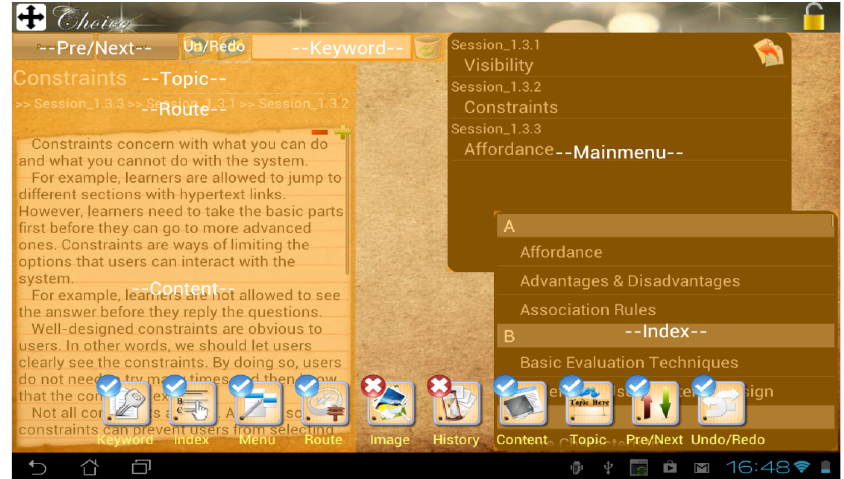
Figure 6. Display Format arranged by Holists